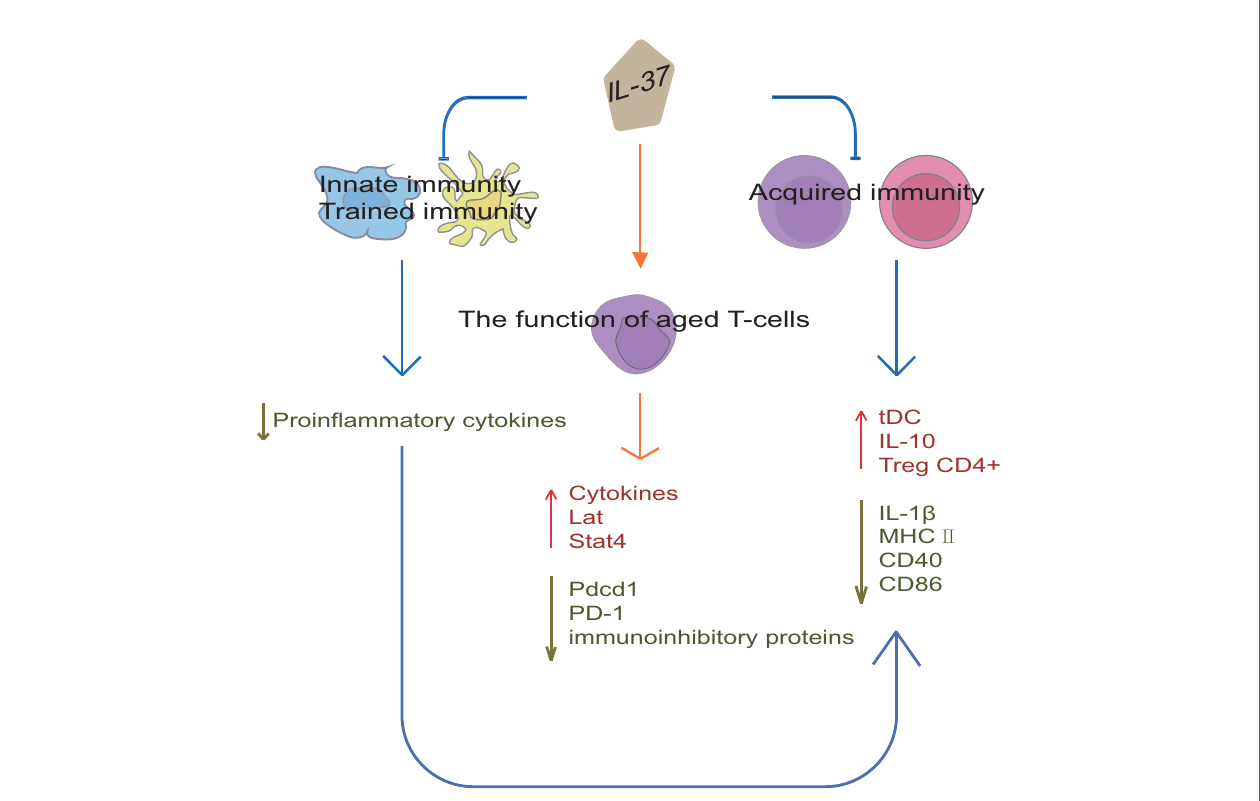
FIGURE 4 | IL-37 regulation of immunity. IL-37 can establish immunological tolerance in the gastrointestinal tract and abolish the protective effects of trained immunity by suppressing pro-in fl ammatory responses. Moreover, IL-37 can inhibit acquired immunity by producing tolerogenic DCs, which promote Tregs expansion and IL-10 expression, and reduce IL-1 b , CD40, CD86 and MHC II expression. The regulation of congenital in fl ammation by IL-37 also affects acquired immunity. Furthermore, IL-37 can promote cytokine production in aged T-cells and reduce the surface expression of programmed cell death protein 1. IL-37 can also restore a youthful gene expression levels of Pdcd1, Lat, and Stat4 in aged T-cells, and reduce the surface expression of immunoinhibitory proteins. Thus, IL-37 not only regulates the innate and acquired immunity, but also improves aging-associated